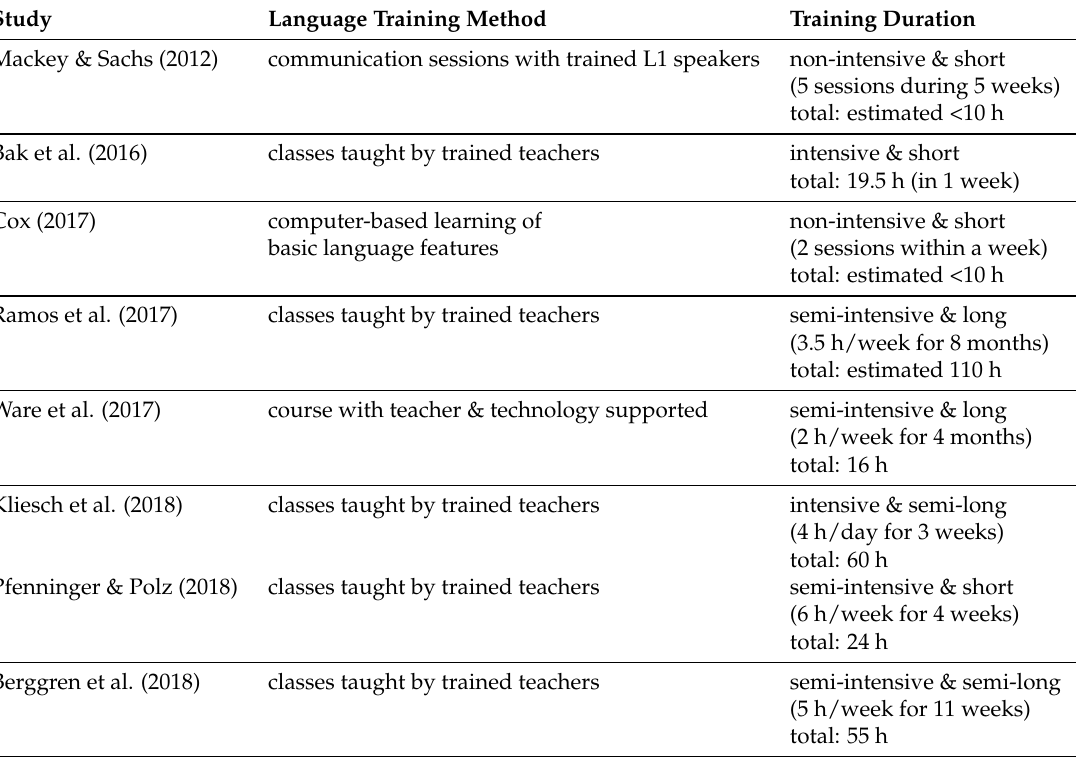
Table 2. Language training method, intensity, and